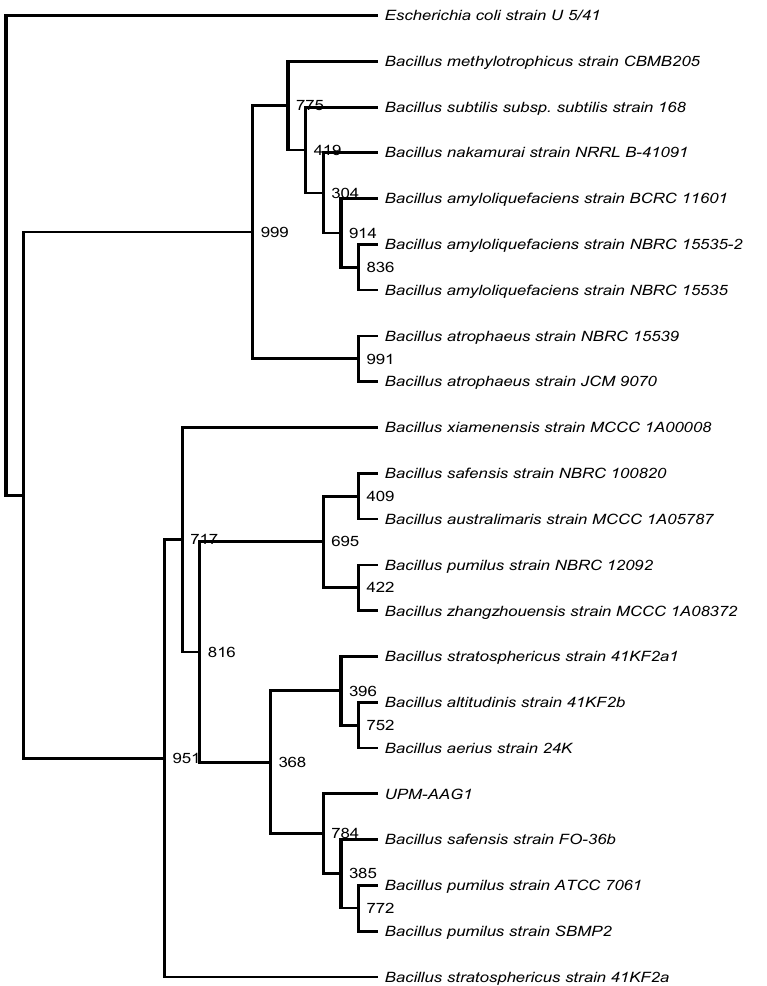
Figure 2. Phylogram (neighbor-joining method) showing the genetic relationship between strain UPM-AAG1 and other related reference micro-organisms based on the 16S rRNA gene sequence analysis. Species names are followed by the strain of their16S rRNA sequences. The numbers at